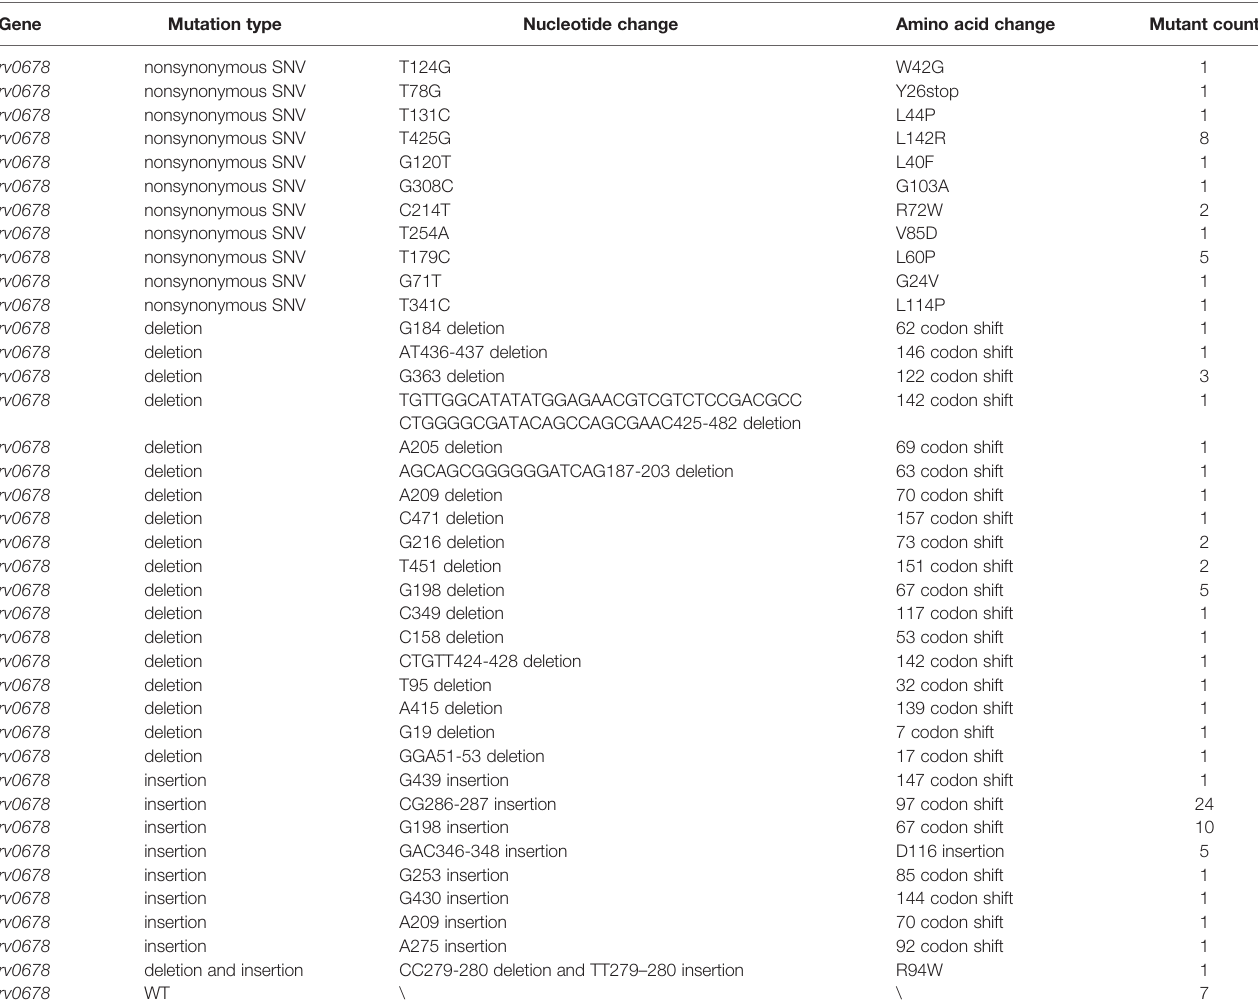
TABLE 1 | Mutation analysis of 101 BDQ-resistant mutants of Mtb by whole-genome sequence